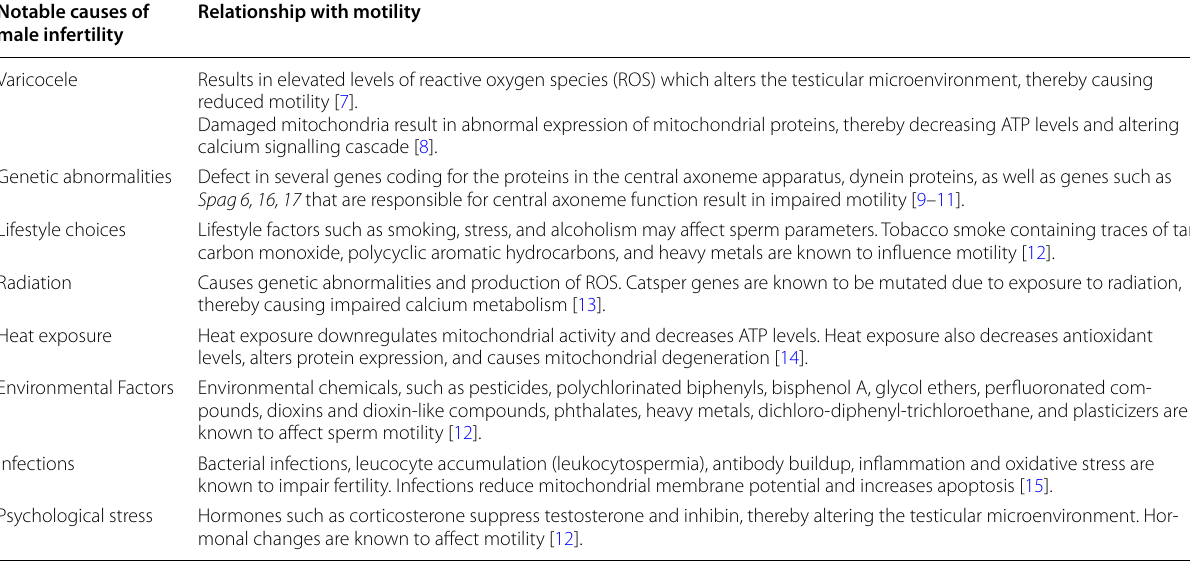
Table 1 List of notable causes of male infertility and their relationship with impaired motility Notable causes of Relationship with male infertility